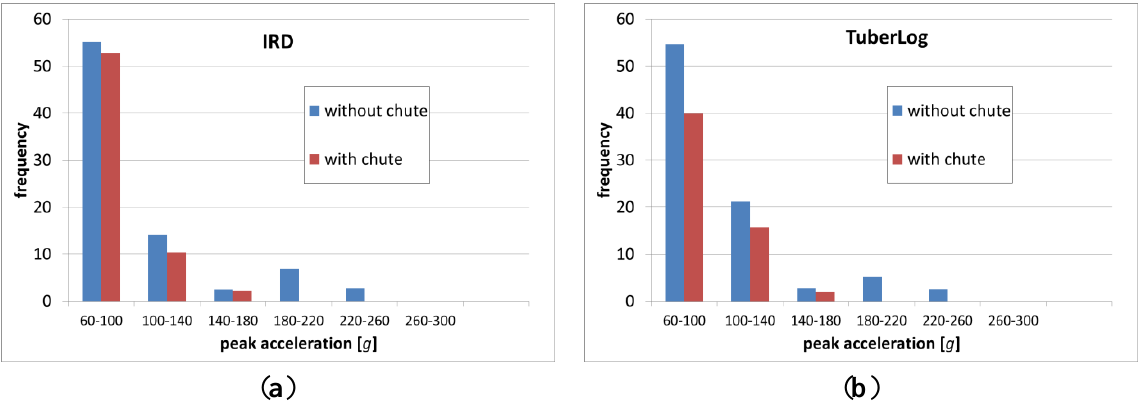
Figure 10. Frequency distribution of impacts with peak acceleration of ≥60 g measured with IRD ( a ) and TuberLog ( b ) during 10 runs through a processing line simulator (conveyor speed 0.35 m·s −1